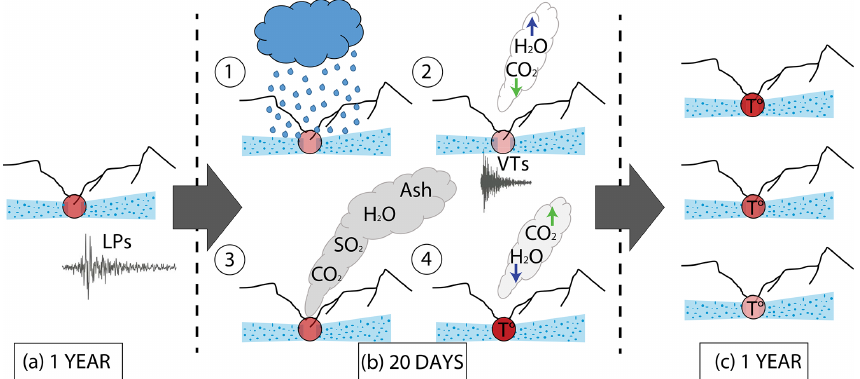
Figure 8. Schematic interpretation of the pre-, co- and post-eruptive processes associated with the 30 October 2015 phreatic eruption of Lascar volcano. The light-blue zones represent the approximate location of the hydrothermal system of Lascar. (a) The pre-eruptive phase started approximately 1 year before the eruption, showing a sustained increase in LP activity. (b) Ten days before the eruption, a 20d phase initiated after being triggered by precipitation on 20 October. This phase developed in four stages: (1) an unusually strong precipitation event occurs; (2) meteoric water percolates into the crater, changes the water content and CO 2 concentration in the fumarole, and reactivates VT activity; (3) the volcano is pushed into a steam-driven explosion, producing a 1.7km high eruption column above the crater that is composed mainly of water, ash, CO 2 and SO 2 , causing the crater floor to fracture; (4) post-eruptive degassing transpires with a hotter fumarole containing more CO 2 and less water, and a thermal anomaly is present in the active crater; and (c) the post-eruptive permanent thermal anomaly slowly decreases in temperature for 1